Question: Which kind of chart has been used to present this data?
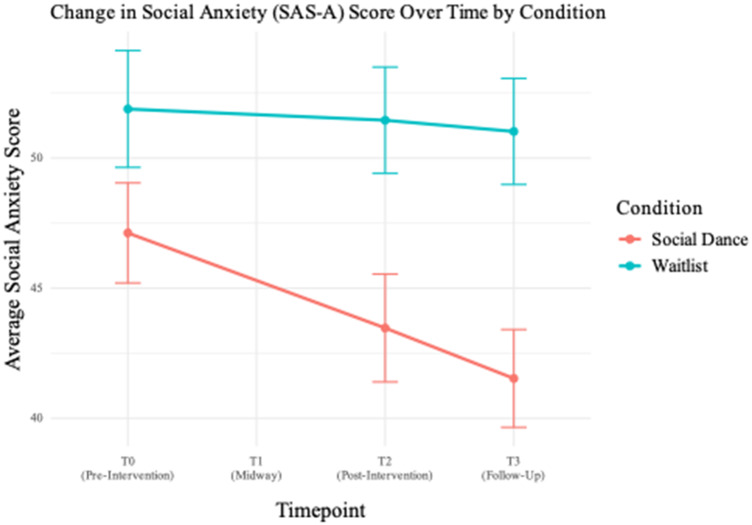
Answer: line